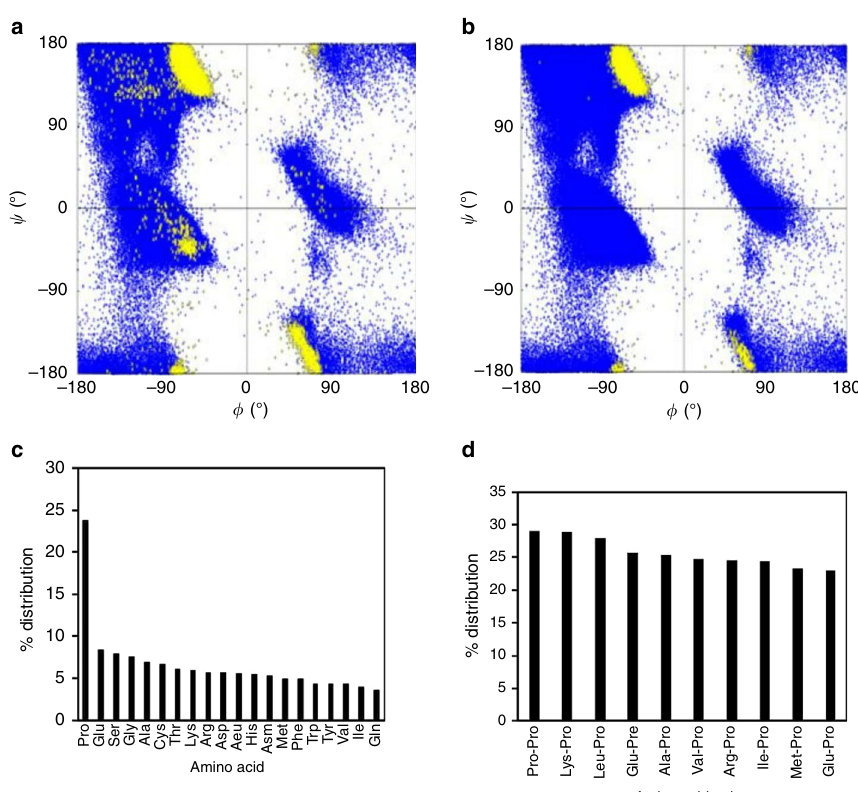
Fig. 5 Ramachandran plots and analyses of reciprocal interactions in proteins. a Ramachandran plot generated by plotting torsion angles ( φ , ψ ) of all residues in 2184 protein structures ( blue ) and torsion angles ( φ , ψ ) of the residue between the two interacting carbonyl groups involved in reciprocal C ═ O ··· C ═ O interactions ( yellow ). b Ramachandran plot generated by plotting torsion angles ( φ , ψ ) of all residues in 2184 protein structures ( blue ) and torsion angles ( φ , ψ ) of the residue between the two interacting carbonyl groups involved in reciprocal C ═ O ··· C ═ O interactions present only in the coil regions ( yellow ). c Plot showing percentage distribution of amino acids involved in reciprocal C ═ O ··· C ═ O interactions. d Plot showing percentage distribution of amino acid pairs involved in reciprocal C ═ O ··· C ═ O interactions